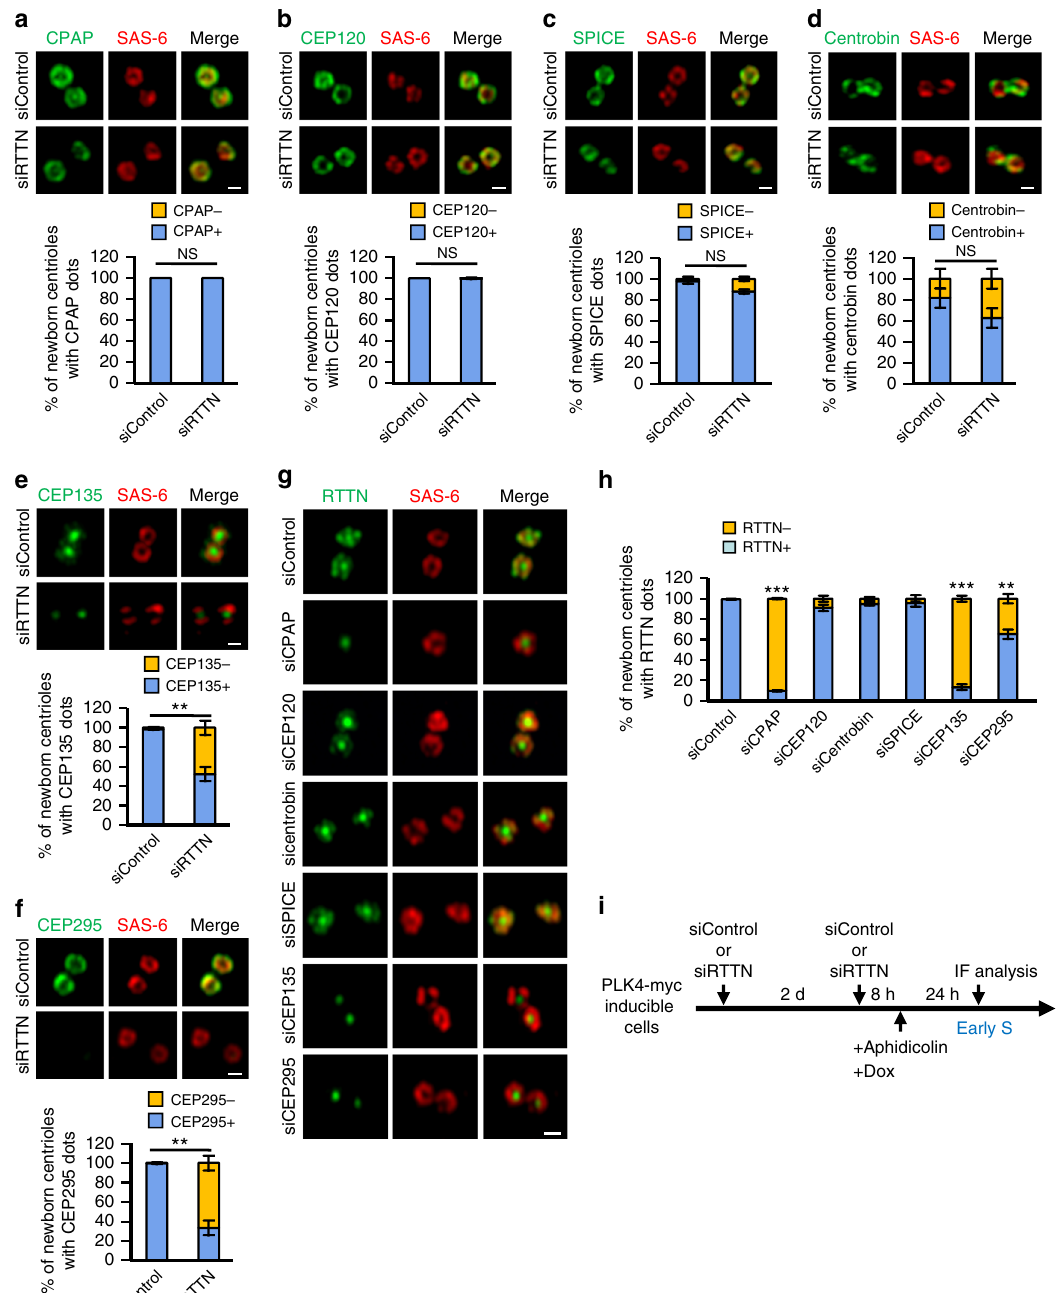
Fig. 6 Delineation of the RTTN-mediated centriole elongation pathway. a – f PLK4-myc-inducible cells were treated with siControl or siRTTN as shown in i and analyzed by confocal fl uorescence microscopy using antibodies against SAS-6 a – f , CPAP a , CEP120 b , SPICE c , centrobin d , CEP135 e , or CEP295 f , and the results were quanti fi ed. Error bars represent the mean ± s.d. ( n = 3 independent experiments with 100 cells scored per experiment). g PLK4-myc- inducible cells were treated with siRNAs against CPAP, CEP120, SPICE, centrobin, CEP135, or CEP295 as shown in i , and analyzed by confocal fl uorescence microscopy using the indicated antibodies. h Histogram illustrating the percentages of newborn centrioles with RTTN dots. Error bars represent the mean ± s.d. ( n = 3 independent experiments with 100 cells scored per experiment). ** P < 0.01; *** P < 0.001; NS, not signi fi cant (two-tailed t -test). i Schematic of the procedure used to analyze the recruitment of centriolar proteins in siRNA-treated PLK4-myc-inducible cells. Scale bar , 0.5 μ m